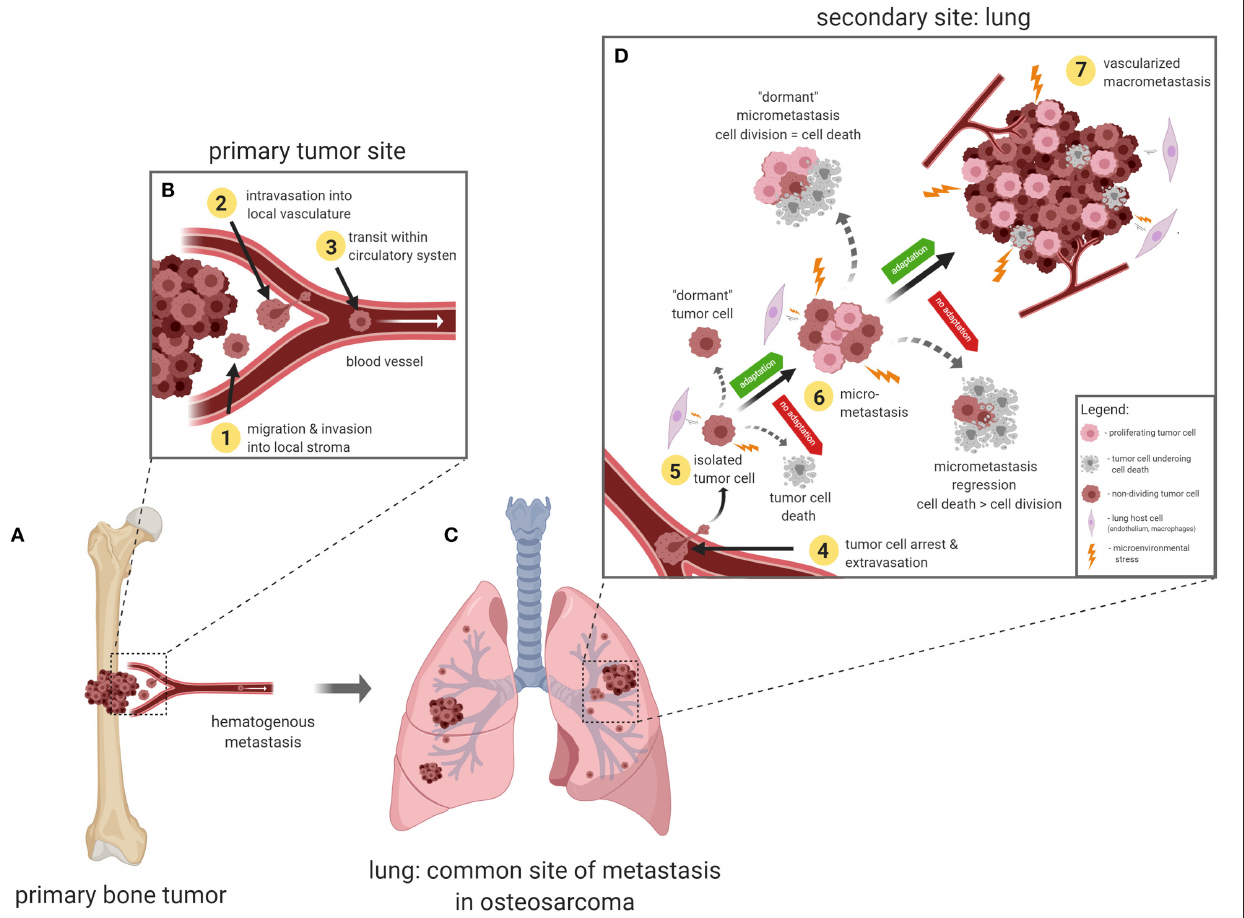
FIGURE 1 | The metastatic cascade in osteosarcoma. (A) Primary OS tumor, usually in the long bones. (B) Tumor cells acquire an invasive phenotype and migrate away from the primary tumor and invade into surrounding tissues (step 1). Tumor cells interact with the basement membrane and endothelial cells to intravasate into the blood microvasculature (step 2) and travel in the circulation (step 3). (C) Upon arrival at the secondary site (lung), tumor cells arrest via size restriction or adhesion interactions with the pulmonary microvascular endothelial cells (step 4). (D) Once tumor cells extravasate out of the blood vessels, they must be able to adapt and survive in the lung microenvironment (step 5). At this vulnerable stage, tumor cells can undergo a number of fates which include- enter cellular dormancy, die off, or if the stresses of the lung microenvironment can be successfully managed, tumor cells can proliferate into multi-cellular micrometastases (step 6). Micrometastases